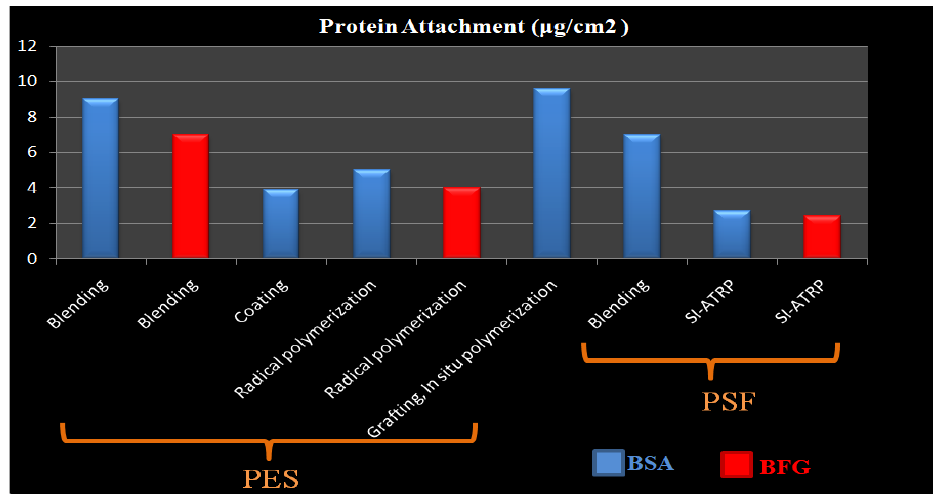
Figure 17. Comparison of protein attachment on modified SB zwitterionic-PES/PSF via different methods.